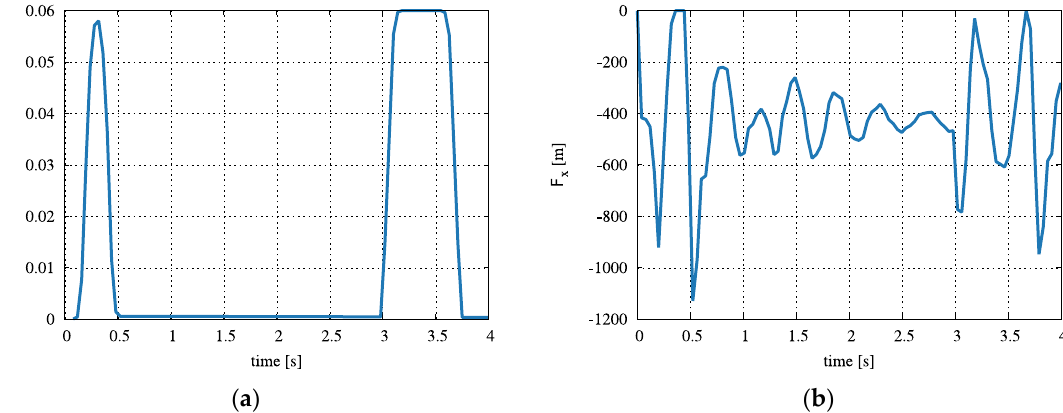
Figure 20. A sketch presenting a computer simulation of driving over speed bumps.